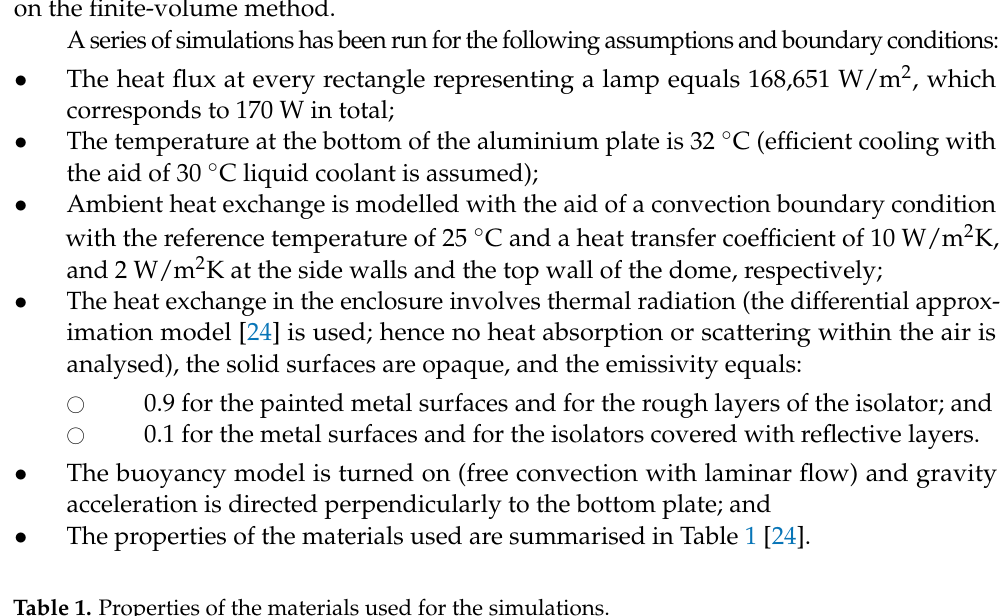
Table 1. Properties of the materials used for the